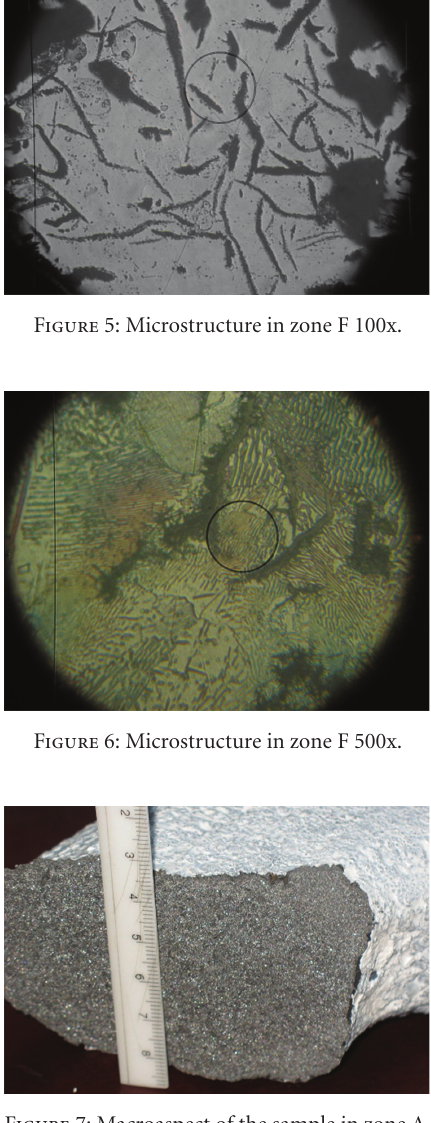
Figure 4: Microstructure in zone F 100x.